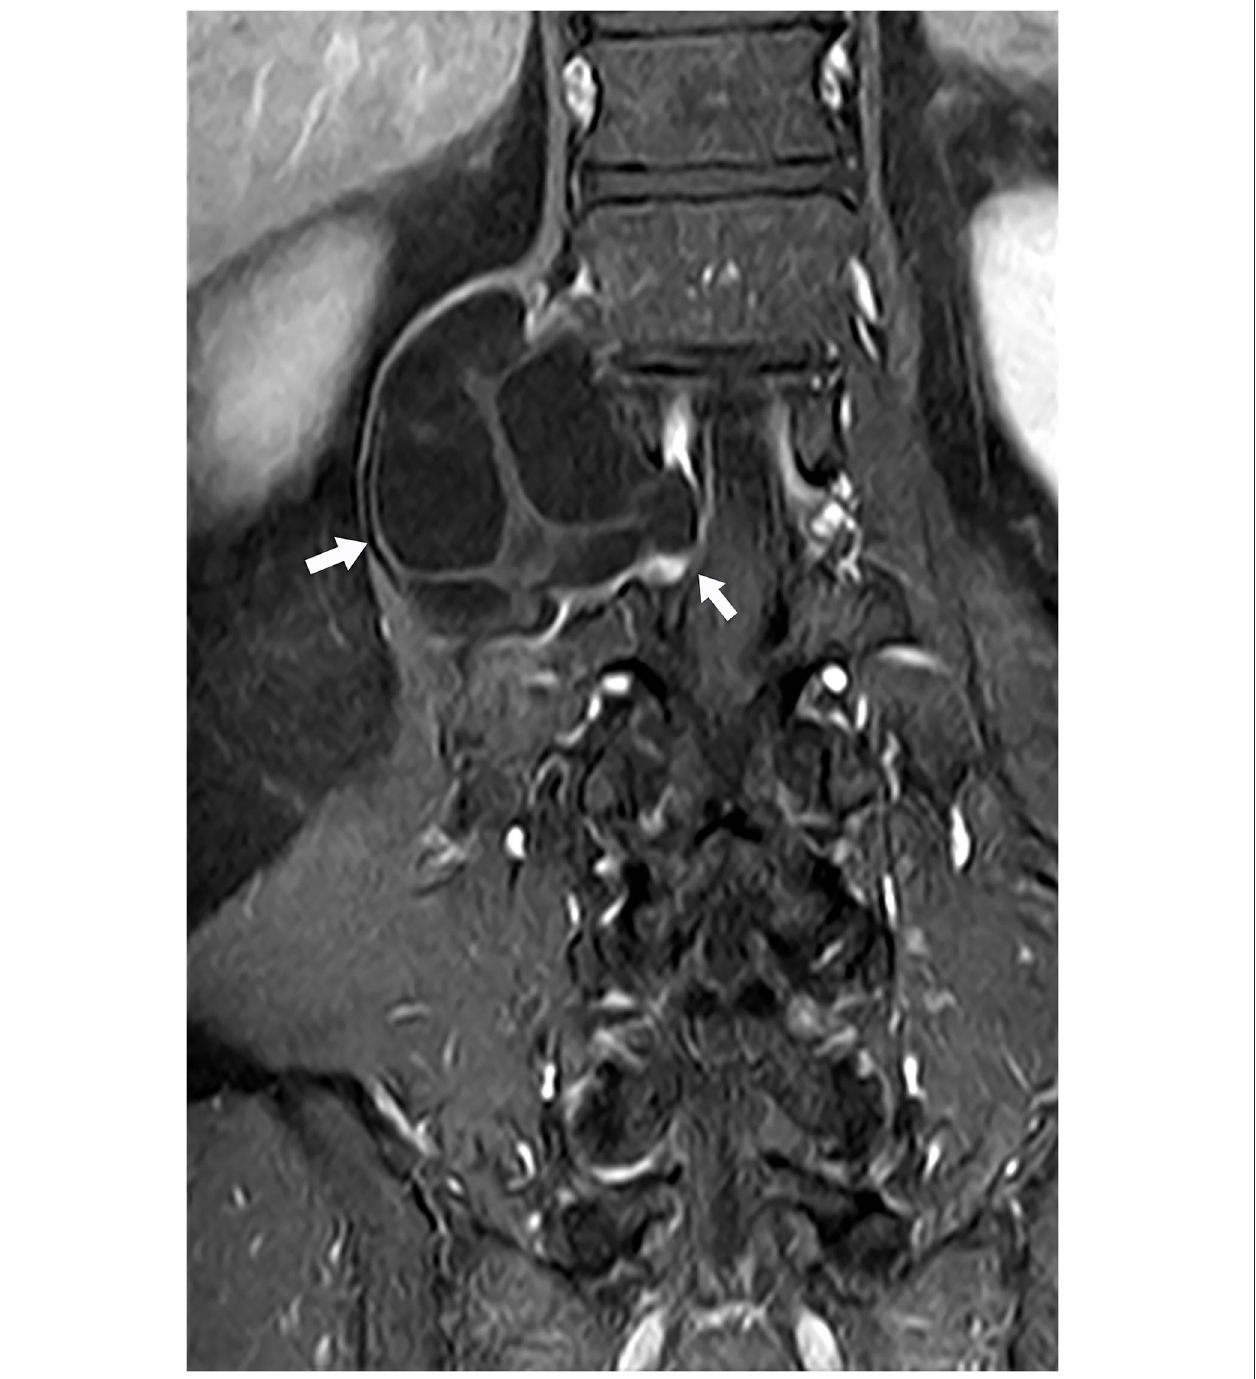
FIGURE 2 | MRI T1WI (coronal image) showing corresponding intervertebral foramina around the cavity was enlarged. Left arrow: The part outside of the spinal canal. Right arrow: The part passing through the intervertebral foramen and inside of the spinal canal.